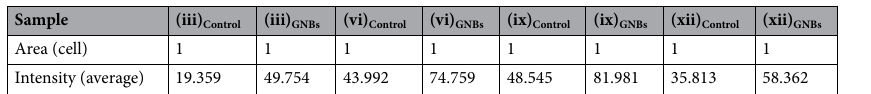
Table 6. Fluorescence intensity values of control cells and experimental cells (incubate with GNBs with an aspect ratio of 2.92) in Fig. 6a.